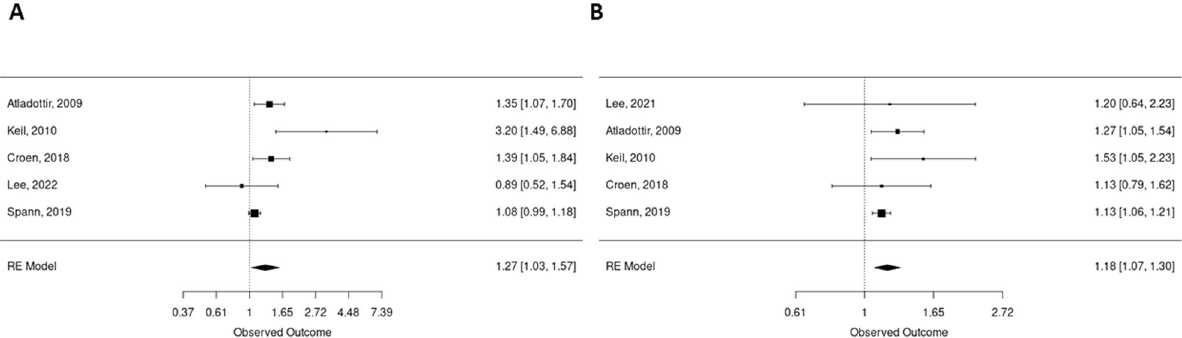
Fig. 2 Forest plot showing the meta-analysis results of the association between AID in parents and ASD in the offspring (adjusted). A Mothers B Fathers. Each square represents individual study effect. Its size represents the study weight in the overall analysis. The black lines on either side of the squares represent the con fi dence intervals. The diamond at the bottom represents the summary effect with the outer edges representing the con fi dence intervals. Square or diamond on the right of the central bar (i.e., superior to 1) represents a positive association between maternal AID and ASD in the offspring. To be signi fi cant, the con fi dence interval lines must not cross